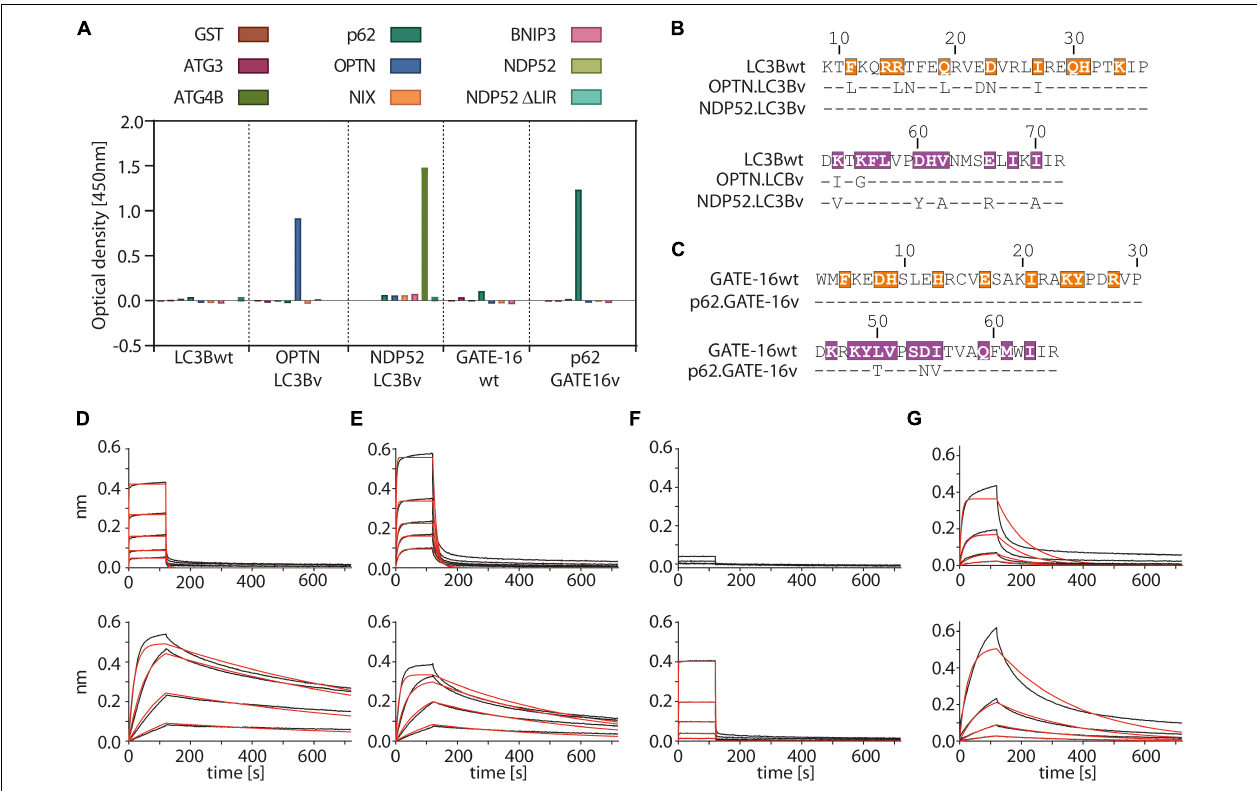
FIGURE 2 | Variants of LC3B and GATE-16 are selective to their cognate LIR and have high affinity in vitro . (A) Phage ELISA of LC3Bwt and GATE-16wt and selected variants with specificity to the LIR motifs of OPTN, p62 or NDP52. Binding of OPTN.LC3Bv and p62.GATE-16v was tested against ATG3, ATG4B, p62, OPTN, NIX and BNIP3. Variant NDP52.LC3Bv was tested against p62, OPTN, BNIP3, NIX, NDP52 and NPD52 (cid:49) LIR. Background correction to BSA signal was applied. (B,C) Sequences of the LC3B and GATE-16 variants with binding to OPTN, NDP52 and p62. Dashes indicate wt residues. Color coding of region 1 and region 2 as in Figure 1C . (D–G) Biolayer interferometry (BLI) measurements of LC3Bwt, GATE-16wt (upper panels) and engineered variants (lower panels) against their cognate LIR-peptide. (C) LC3Bwt and OPTN.LC3Bv binding to OPTN peptide. (D) LC3Bwt and OPTN.LC3Bv binding to pS177 OPTN peptide. (E) LC3Bwt and NDP52.LC3Bv binding to NDP52 LIR peptide. (F) GATE-16wt and p62.GATE-16v binding to p62 LIR peptide. TABLE 1 | Binding constant K D of wt controls and engineered variants to their cognate peptides (nM).